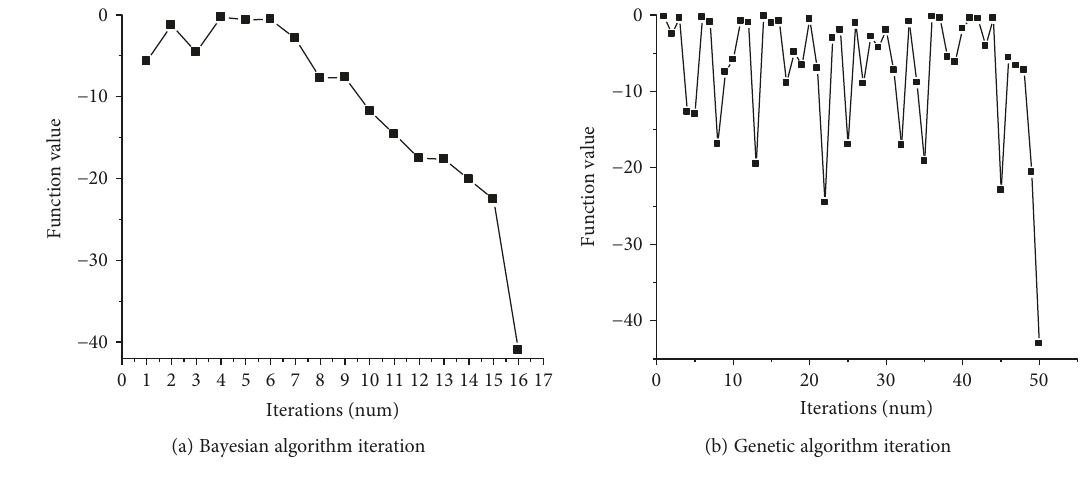
(b) Genetic algorithm iteration